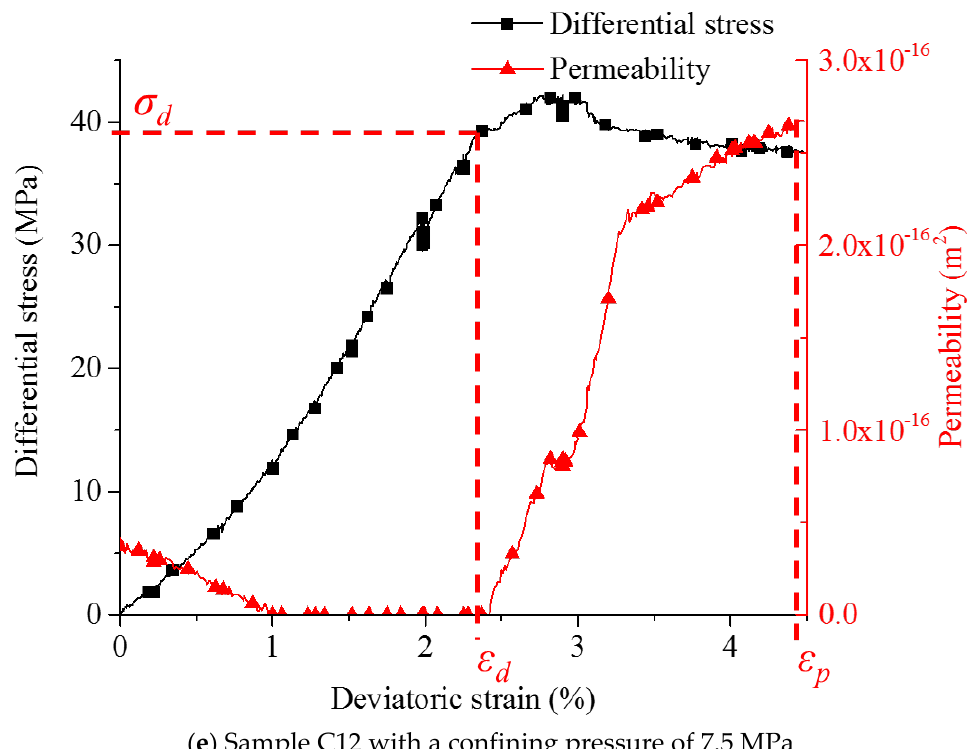
Figure 14. Permeability evolution and complete stress – strain curves for triaxial compression tests.